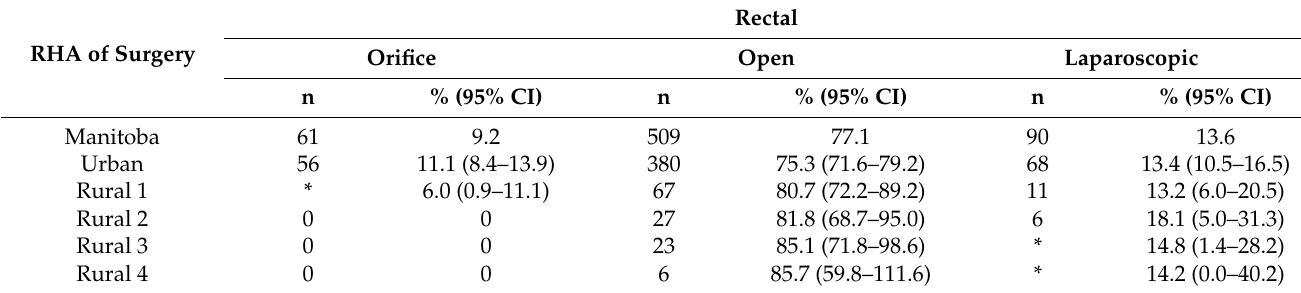
Table 3. Surgical Approach by Regional Health Authority of Surgery for Rectal Cancers, 2010–2015.